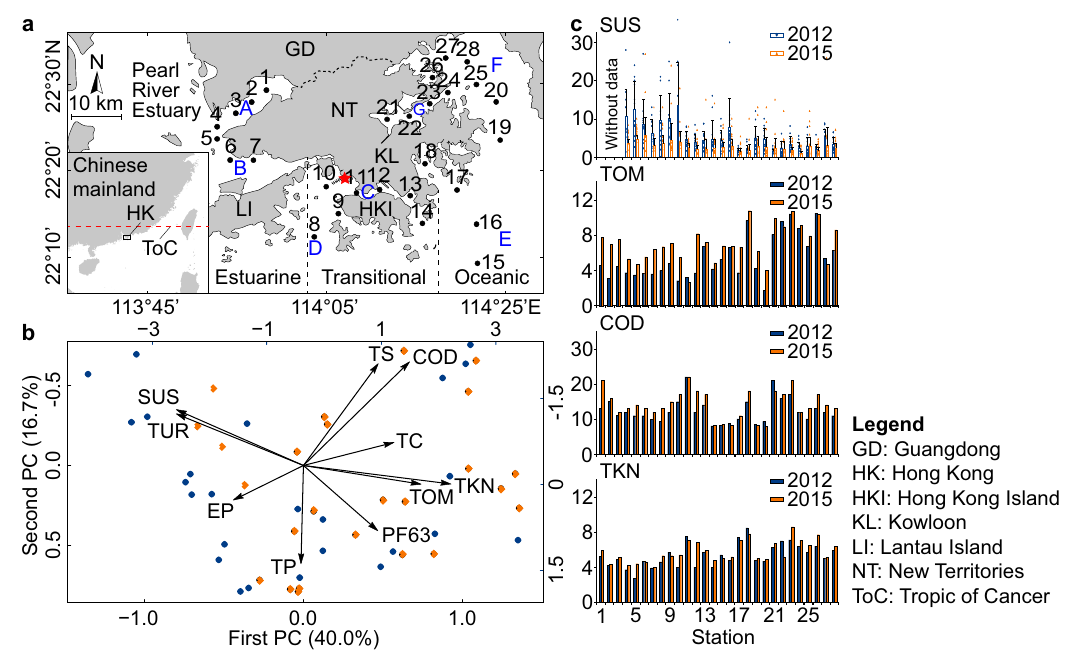
Fig. 2 Survey sites in Hong Kong waters and comparison of abiotic parameters before (2012) and after (2015) the trawl ban. a The 28 survey sites located in three hydrological regions (i.e. Estuarine, Transitional and Oceanic) and seven Water Control Zones (i.e. (A) Deep Bay, covering sites 1, 2, 3, 4; (B) Western Waters, covering sites 5, 6, 7; (C) Victoria Harbour, covering sites 9 and 10 outside the harbour, and sites 11, 12, 13, 14 inside the harbour; (D) Southern Waters, covering site 8; (E) Eastern Waters, covering sites 15, 16, 17, 18, 19; (F) Mirs Bay, covering sites 20, 25, 26, 27, 28; (G) Tolo Harbour, covering sites 21, 22, 23, 24) in Hong Kong. The red pentagram represents the location of Stonecutters Island. b Principal components analysis (PCA) biplot showing changes in abiotic variables towards increased total organic matter and decreased suspended-solid loads in the survey sites after the trawl ban. Blue and orange circles represent data from the 2012 and 2015 surveys, respectively. Positive or negative correlations between abiotic variables and the two principal components are represented by the direction of the arrows. Abbreviations of abiotic variables refer to Supplementary Table 1. c Abiotic variables with signi fi cant changes (paired samples t -tests) between the 2012 and 2015 datasets. For SUS in c , error bars represent the means + standard deviation (SD) of 11 or 12 independent experiments. Between 2012 and 2015, there was a signi fi cant decline in bottom water SUS (mg/L), but signi fi cant increases in sedimentary TOM (w/w%), COD (1000 mg/kg) and TKN (100